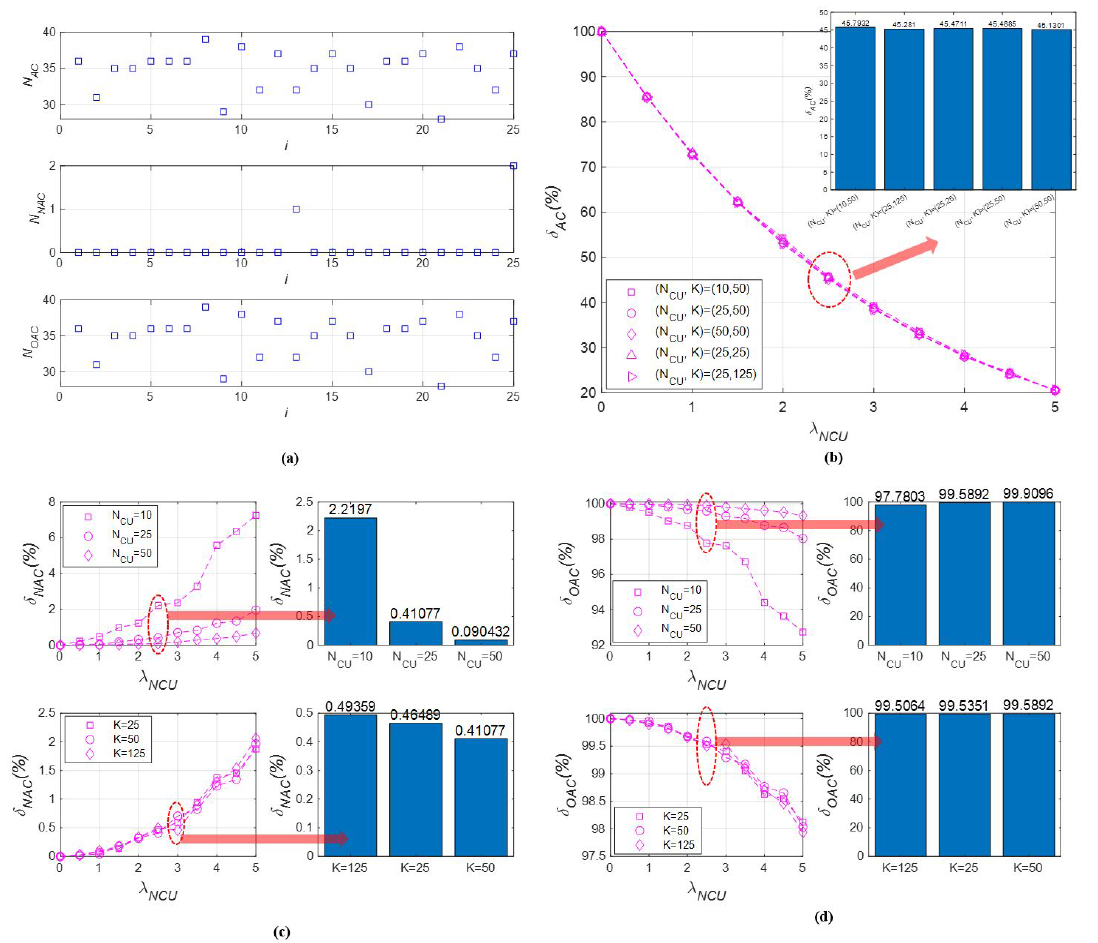
Figure 9. The results of the asymmetry of available channels analysis: ( a ) a snapshot of N AC , N NAC , and N OAC at N CU of 25, K of 50, and λ NCU of 1.5; ( b ) δ AC according to λ NCU , K , and N CU ; ( c ) δ 𝑁𝑁 𝑀𝑀𝑁𝑁 , 𝑁𝑁 𝑁𝑁𝑀𝑀𝑁𝑁 ,